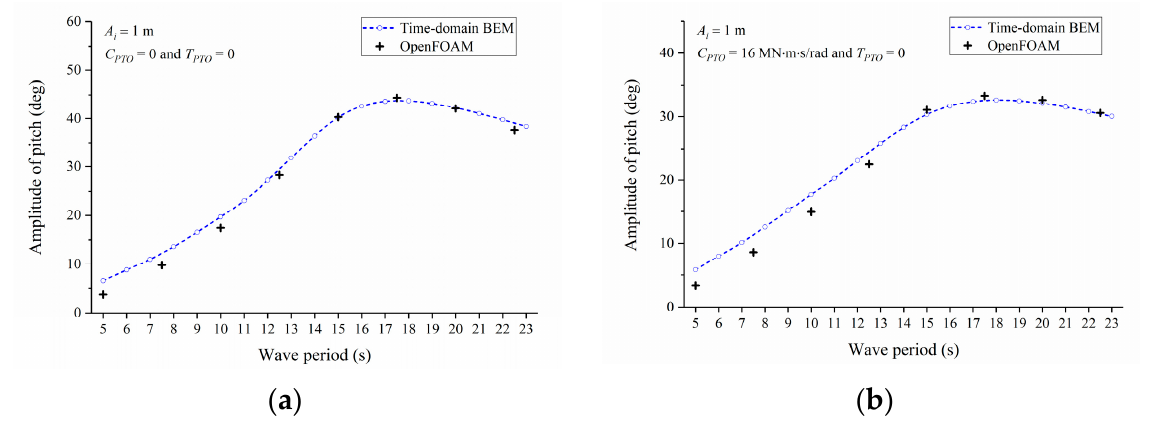
Figure 17. The comparison of pitch amplitude under regular waves of unit-amplitude between BEM and CFD of a no-friction flap ( T PTO = 0) with different PTO damping: ( a ) C PTO = 0; ( b ) C PTO = 16 MN · m · s/rad.